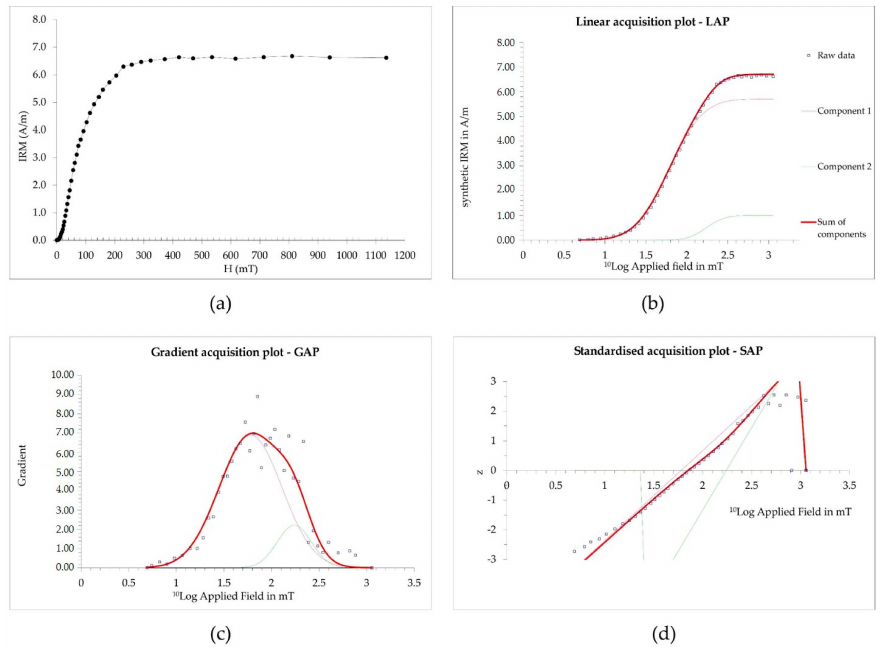
Figure 6. Analyses of ES19-A1 sample using the Kruiver et al. software [1]. ( a ) IRM acquisition curve analyzed using a Cumulative Log-Gaussian (CLG) function. ( b ) IRM curve adjustment versus the logarithm of the field applied to a linear scale (LAP). ( c ) IRM curve adjustment versus the logarithm of the field applied expressed as a gradient (GAP). ( d ) IRM curve adjustment versus the logarithm of the field applied to a probability scale